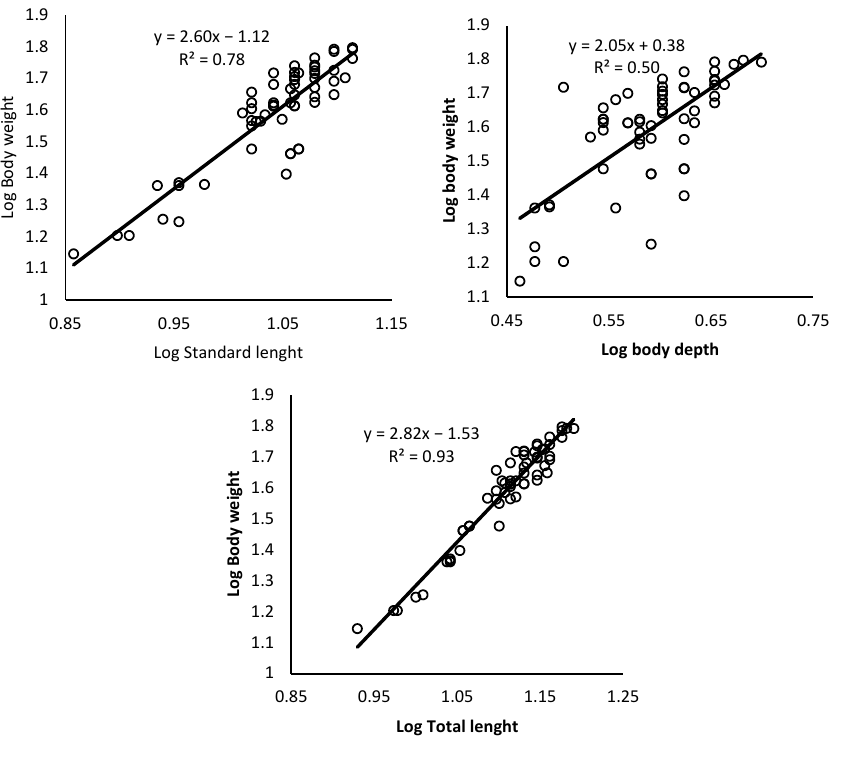
Figure 4. Descriptive statistics and estimated parameters of length–weight and depth–weight rela- tionships.